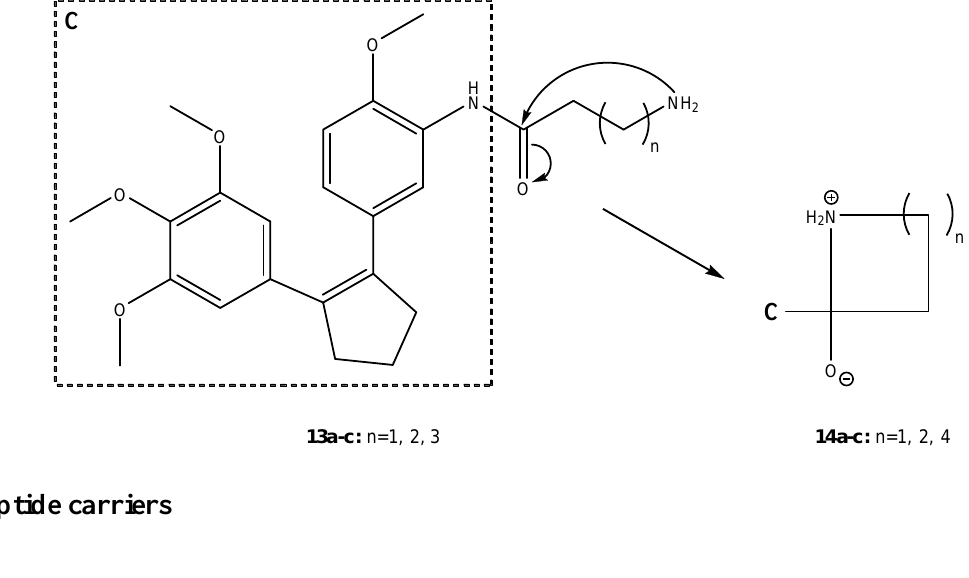
Scheme 9. Intermediates in the intramolecular aminolysis of prodrugs 13a-c